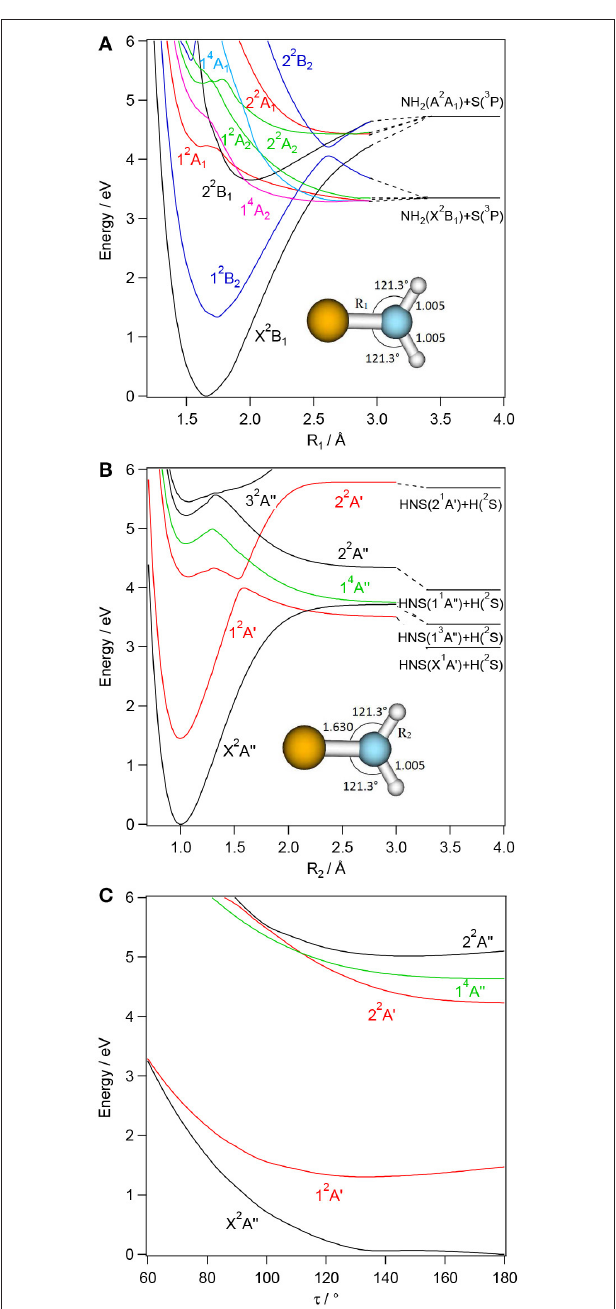
FIGURE 3 | CASSCF/MRCI/aug-cc-pV(5 + d)Z one-dimensional cuts of the 6D-PESs of the low-lying electronic states of H 2 NS along the NS (R 1 , A ) and NH (R 2 , B ) stretching and τ out-of-plane (C) coordinates. The remaining internal coordinates are kept fixed at their values in the H 2 NS(X 2 B 1 ) state i.e. R 3 = 1.630 Å, R 2 = R 3 = 1.005 Å, θ 1 = θ 2 = 121.3 ◦ and τ = 180 ◦ (for planar configuration). The H + HNS/HSN and NH 2 + S asymptotes are located using the data in Supplementary Tables 8 , 9 and (Xin et al., 2003; Trabelsi et al., 2015) 1 .